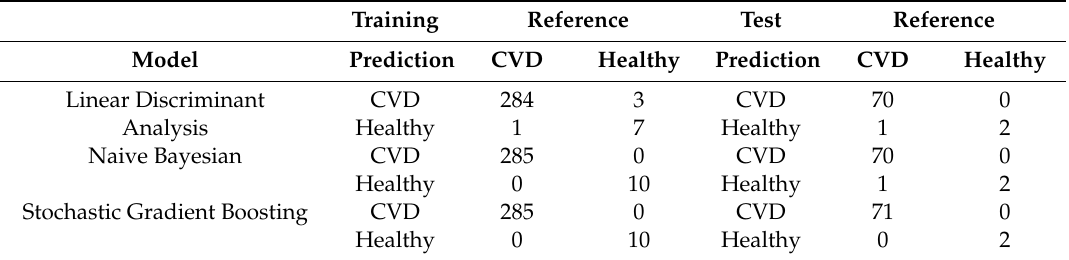
Table 3. Confusion matrices of the linear discriminant analysis, Naive Bayesian and stochastic gradient boosting models.